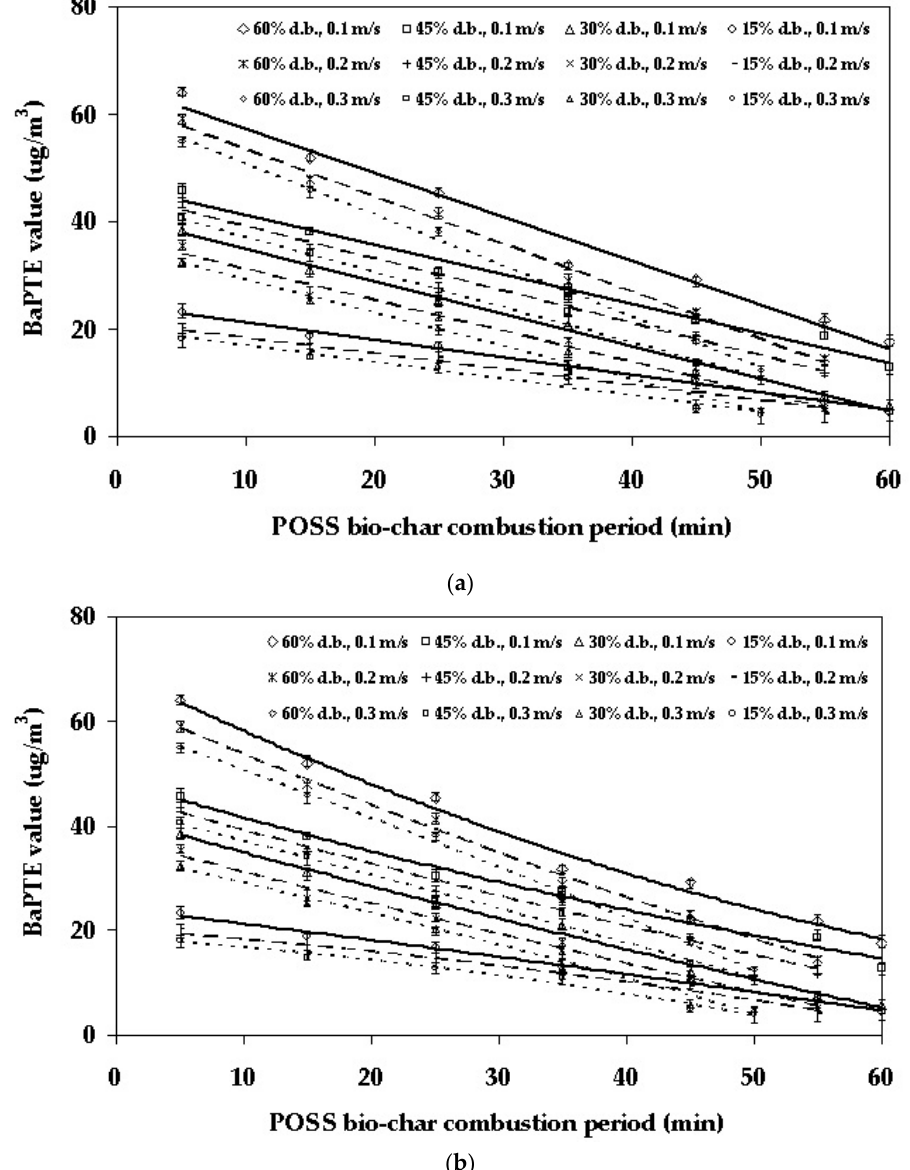
Figure 11. Comparison of predicted and experimental BaPTE values: ( a ) zero-degree model; ( b ) first-degree model.